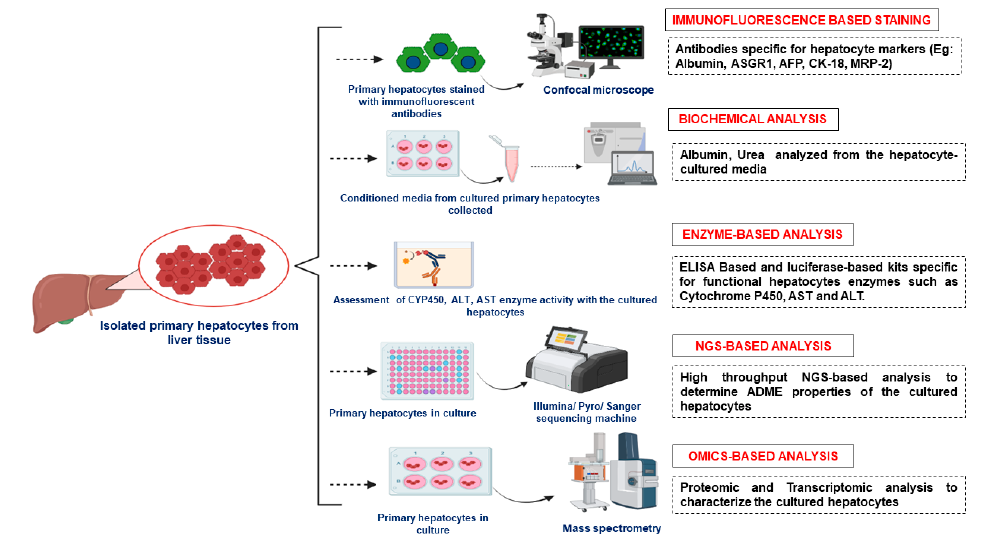
Figure 5. Characterization of the isolated primary hepatocytes using different techniques. ASGR1— Asailoglycoprotein Receptor1, AFP—Alpha Fetoprotein, CK18—Cytokeratin-18, MRP-2—Multi Drug Resistance Protein-2, ELISA—Enzyme Linked Immunosorbent Assay, AST—Aspartate aminotransferase, ALT—Alanine aminotransferase, ADME—Absorption, Distribution, Metabolism and Excretion.